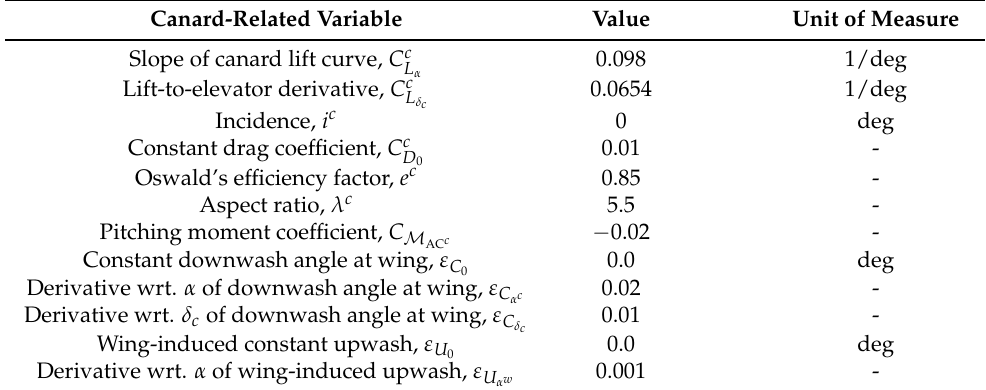
Table 2. Characteristics of the canard surface common to all considered three-surface configurations. Canard-Related Variable Value Unit of Measure Slope of canard lift curve, C c L α